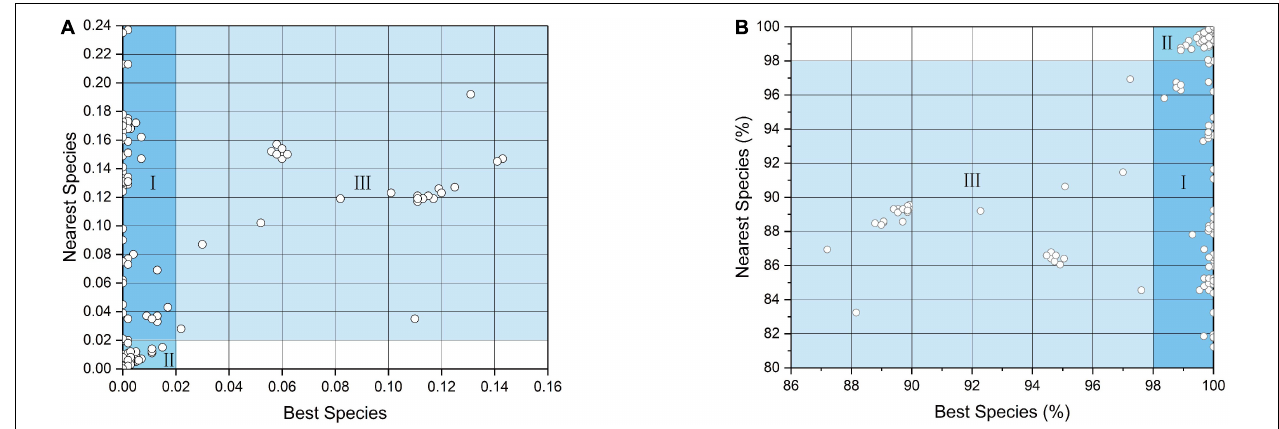
FIGURE 3 | The best match compared with the nearest neighbor for each specimen. (A) Genetic distance, (B) similarity percentage. Case I, delimited to species level; Case II, delimited to genus or uncertain; Case III, unidentified.